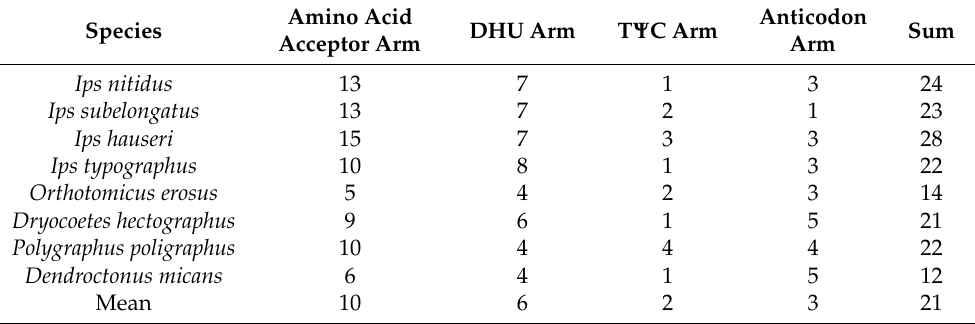
Table 2. Comparison of tRNA secondary structure mismatches in eight bark beetles.